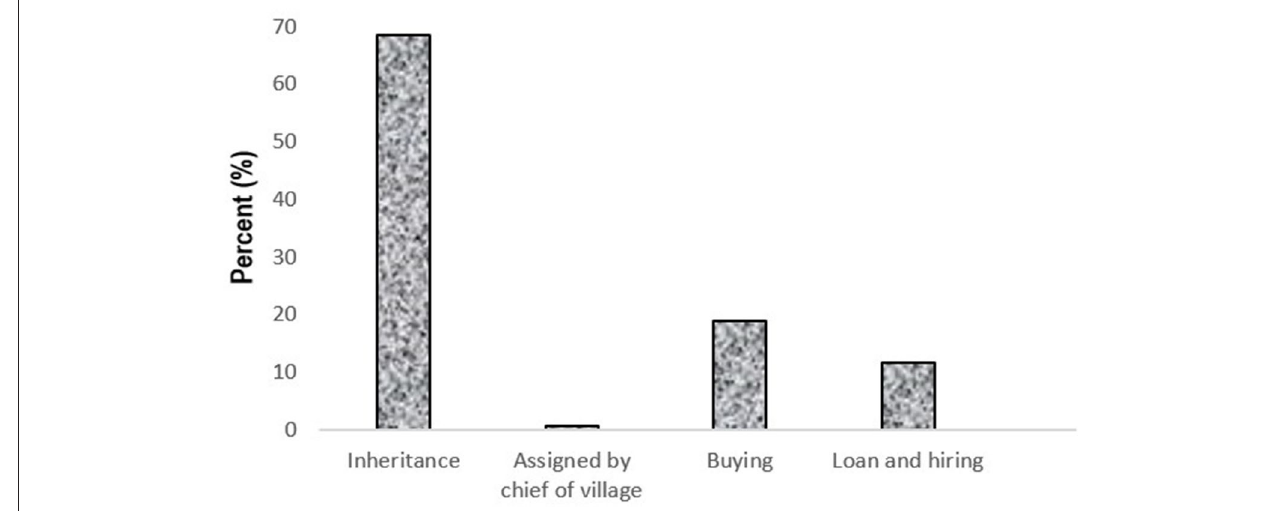
FIGURE 3 | Type of land acquisition.